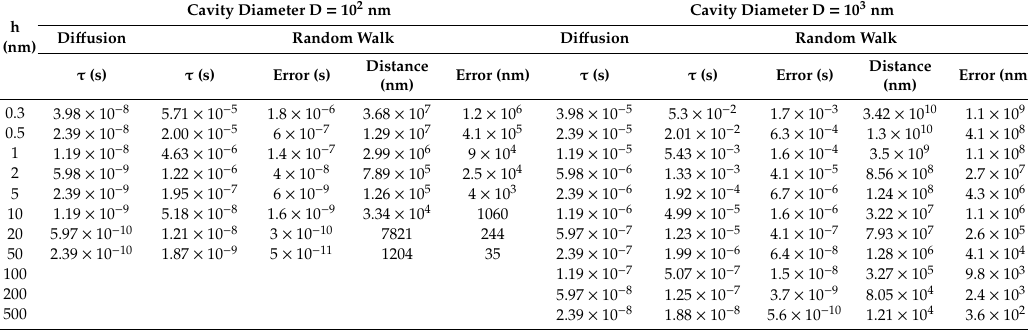
Table A2. Mean escape time ( τ ) of a given molecule, errors and total traveling distance of the confined molecule in a spherical cavity (cavity diameter 10 2 nm and 10 3 nm) for di ff erent entrance–escape hole diameters (h) calculated by the di ff usion and the non-interactive random walk